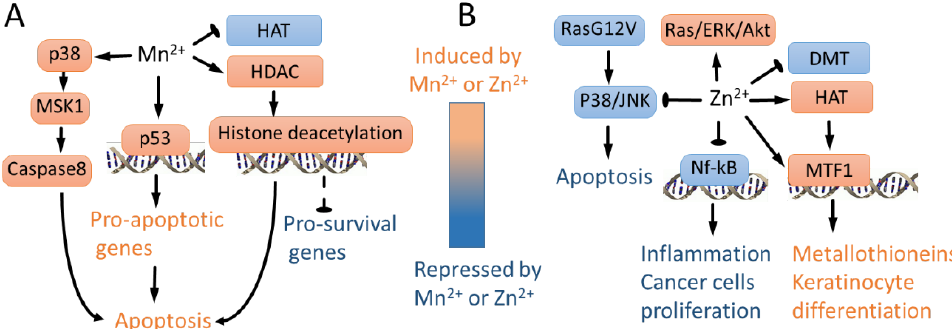
Figure 4. Mn 2+ - and Zn 2+ -regulated signaling pathways. ( A ) Mn 2+ represses global histone acetyla- tion by augmenting HDAC and repressing HAT activity, leading to apoptosis presumably due to repression of key pro-survival genes [19]. In addition, Mn 2+ activates p53 [151–153] and p38/MSK1 signaling [72], leading to apoptosis. ( B ) In wild-type Ras cells, Zn 2+ activates ERK/AKT signaling [146]. In contrast, in mutant G12V RAS cells, Zn 2+ inhibits p38 and JNK, repressing apoptosis [147]. Zn 2+ inhibits Nf-kB, leading to lower proliferation of cancer cells and inhibiting inflammation [144,145,157]. In contrast to Mn 2+ , Zn 2+ activates HAT, leading to metallothionein induction and keratinocyte differentiation-specific gene expression [22]. Consistently, Zn 2+ represses DNA methyl- transferase activity in immortalized mouse fibroblasts [141]. Zn directly regulates MTF1-mediated induction of metallothionein genes [25], leading to expression of keratinocyte differentiation genes [22].